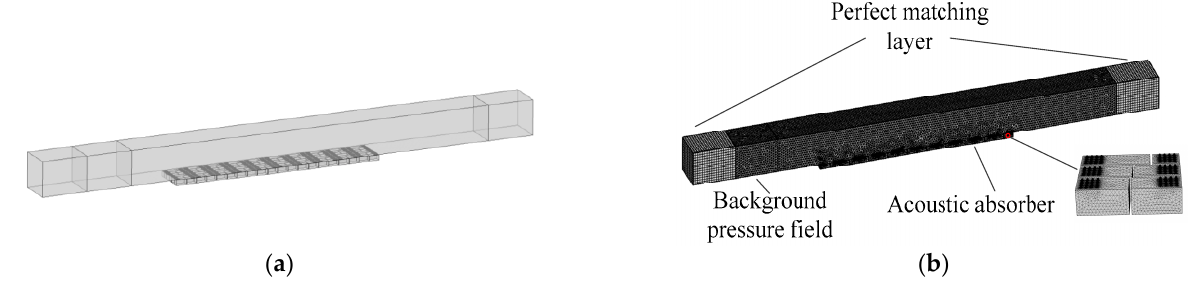
Figure 16. Geometric and detailed FE models of the RDPAA system with grazing flow (suitable for the FNSE method). ( a ) Geometric model and ( b ) FE model.